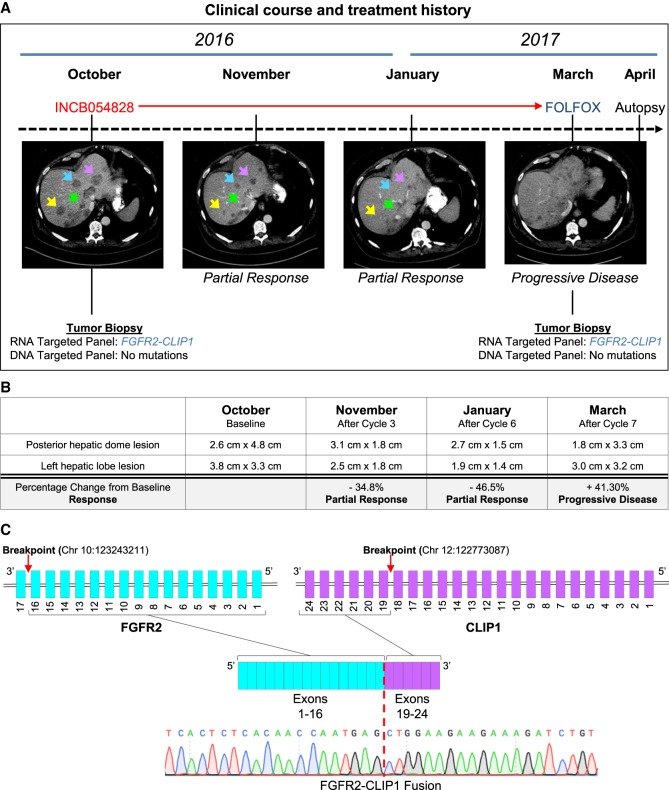
Clinical description of a cholangiocarcinoma patient harboring an FGFR2–CLIP1 fusion. (A) A patient with metastatic cholangiocarcinoma underwent a liver biopsy and sequencing revealed an FGFR2–CLIP1 gene fusion. He received gemcitabine/cisplatin but after two cycles of therapy had disease progression. He was enrolled on INCB54828 and had a profound radiographic response. After 5.5 mo on therapy, he developed progression and passed away shortly thereafter from his disease. A repeat tumor biopsy at the time of progression did not reveal any secondary mutations. (B) Table summarizing two target lesions (posterior hepatic dome lesion and left hepatic lobe lesion) that were tracked throughout the treatment course and had a 34.8% and 46.5% reduction from baseline after cycles 3 and 6, respectively. (C) Schematic of the FGFR2–CLIP1 fusion involving exons 1–16 of FGFR2 and exons 19–24 of CLIP1. Chromatogram traces from Sanger sequencing of the tumor biopsy confirmed the presence of the fusion. Red dashed line indicates breakpoint within the sequence.